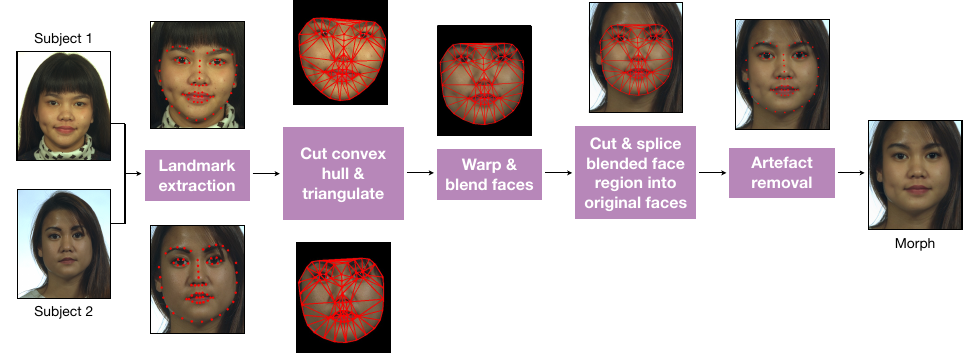
Figure 2. Visualization of the morphing